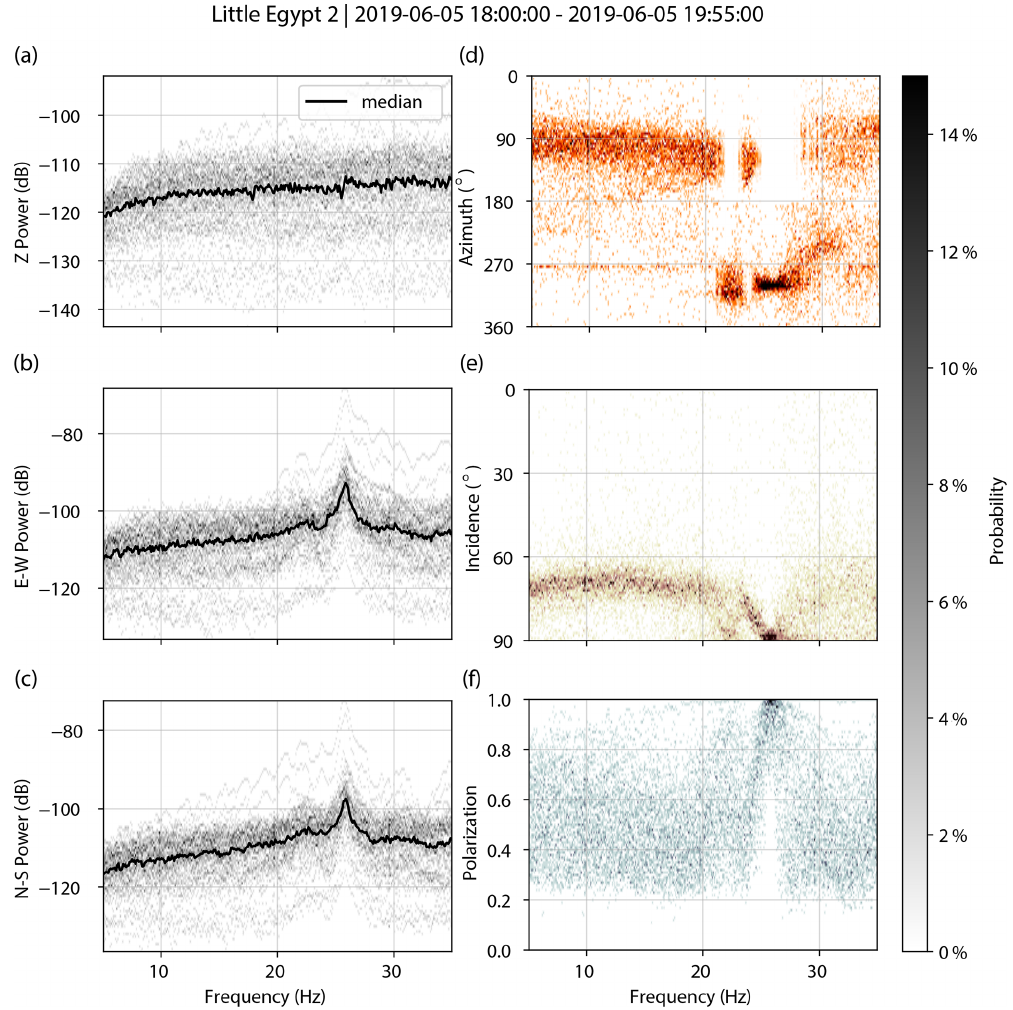
Figure A3. Little Egypt 2. PSDs for vertical (a) , east–west (b) , and north–south (c) components. Decibel powers are relative